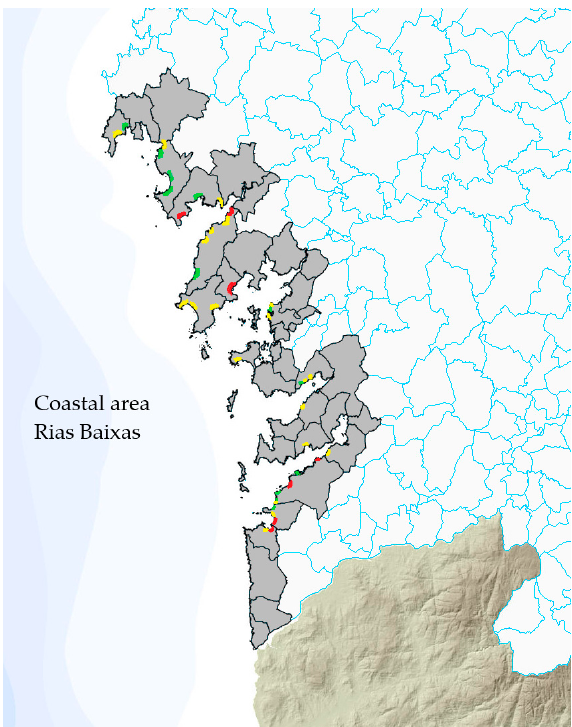
Figure 7. Tourism vulnerability of at risk beaches in Rias Baixas. Green: Beaches with low tourism vulnerability; yellow: medium vulnerability; red: high vulnerability.